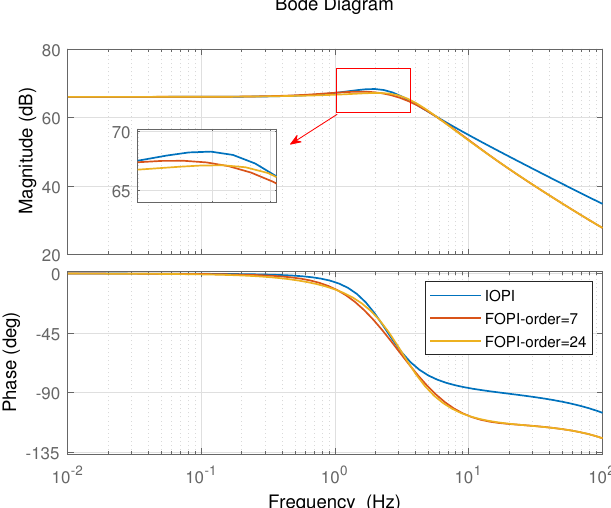
Figure 12. Closed − loop Bode plot with different discretization orders.